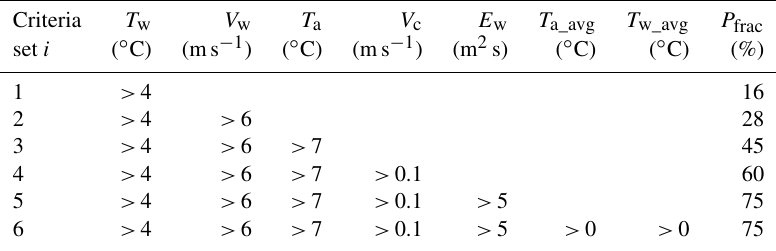
Table 4. Fracture model conditional criteria sets and the associated conditional probability ( P frac ) for extreme conditions. The variables included water temperature ( T w ), wind speed ( V w ), air temperature ( T a ), current speed ( V c ), wave energy index ( E w ), lifetime mean air temperature ( T a_avg ), and lifetime mean water temperature ( T w_avg